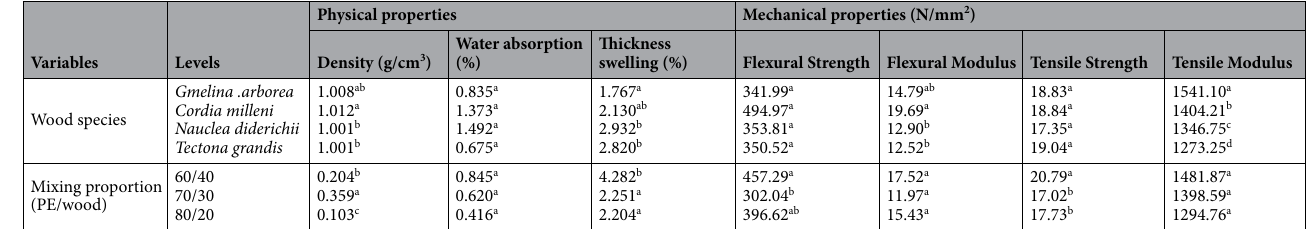
Table 3. Result of duncan multiple range test carried out on the outcome of ANOVA results for physical and mechanical properties. The same letter represents no significance while different letter represents significance to one